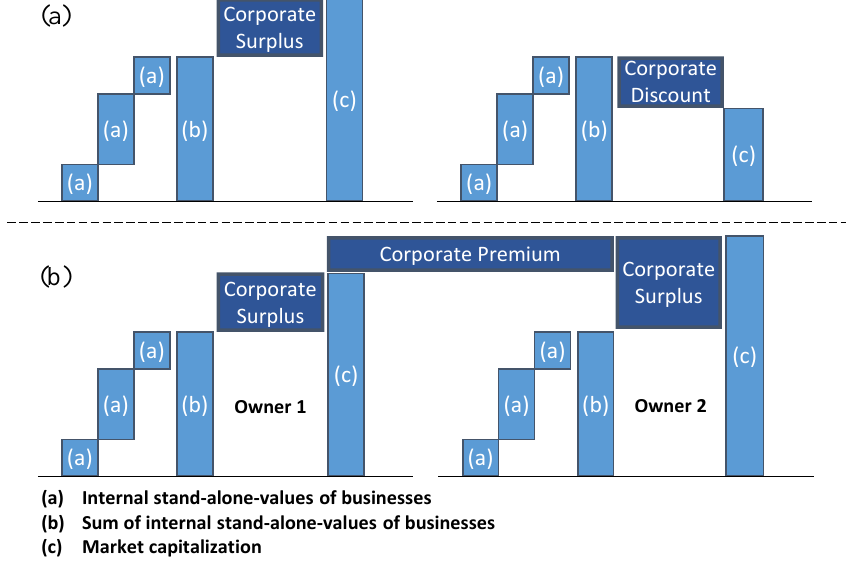
Figure 2. Schematic representation of the ( a ) corporate surplus and corporate discount and ( b ) corporate premium. Own illustration, based on [10] (pp. 52, 56).